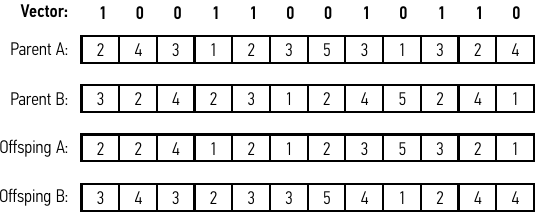
Fig. 5. Representation of lower-level chromosome